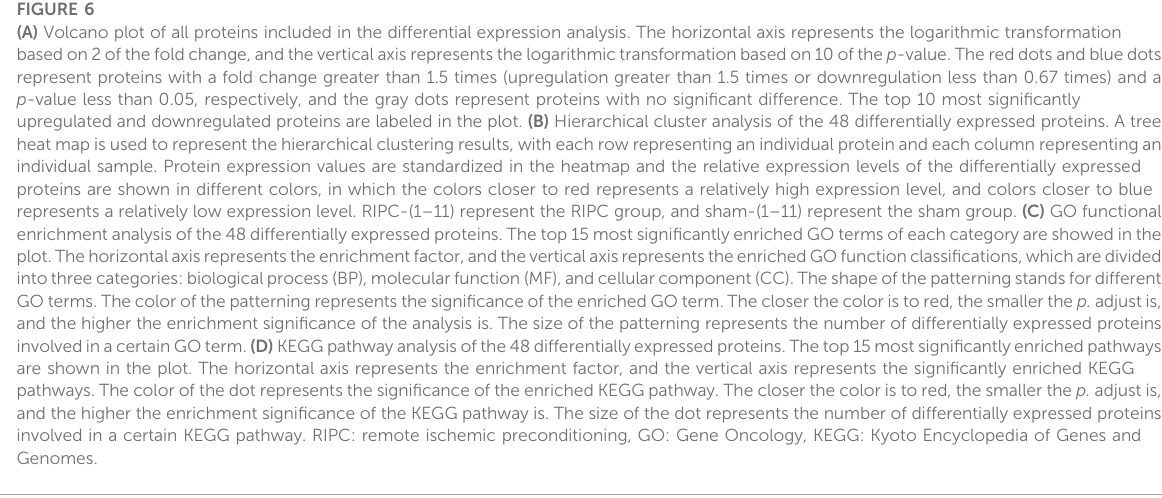
both the maximum (18.13%) and minimum (53%). Overall, rSO 2 can be considered a meta-parameter in fl uenced by ventilation, oxygenation, hemoglobin (Hb) brain perfusion, and metabolism. The normal range of rSO 2 suggests a balance between O 2 supply and consumption in the individual regions of the brain (Scheeren, 2016; Ferraris et al., 2018). In the present study, a marked change in the peripheral rSO 2 value of the left forehead was observed. In